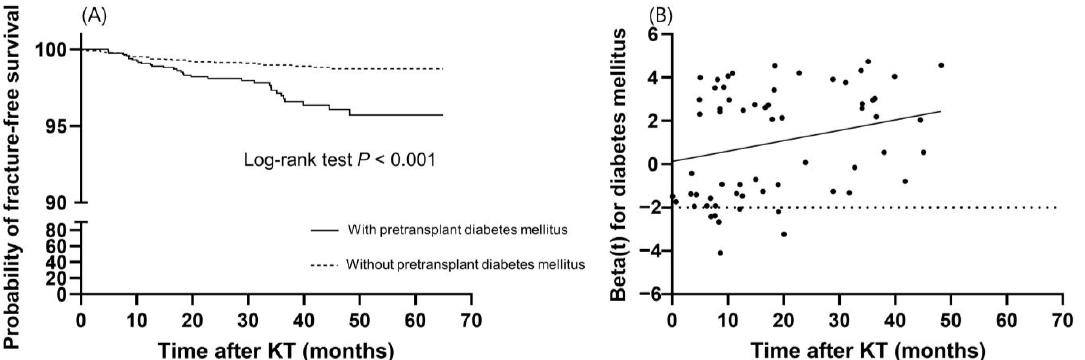
Figure 3. Time-dependent effect of pretransplant diabetes mellitus on fractures. ( A ) Kaplan–Meier survival curve of fracture-free survival according to pretransplant diabetes mellitus. ( B ) The effect of pretransplant diabetes mellitus on fractures over time. The dotted line is the reference line for the null effect. The solid line shows a linear effect with a slope of 0.048.